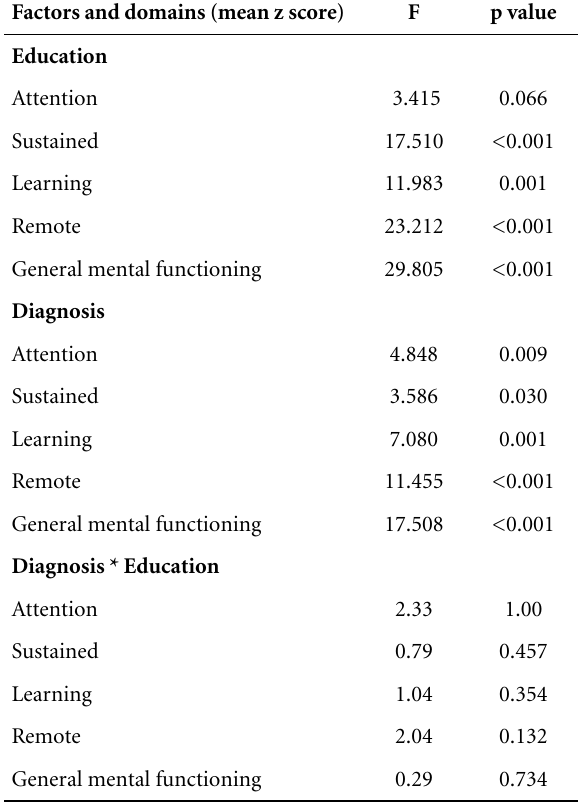
Table 4. Multivariate effect upon domain mean z scores of fac- tors under investigation (diagnostic status, educational attain- ment and interaction between diagnosis and